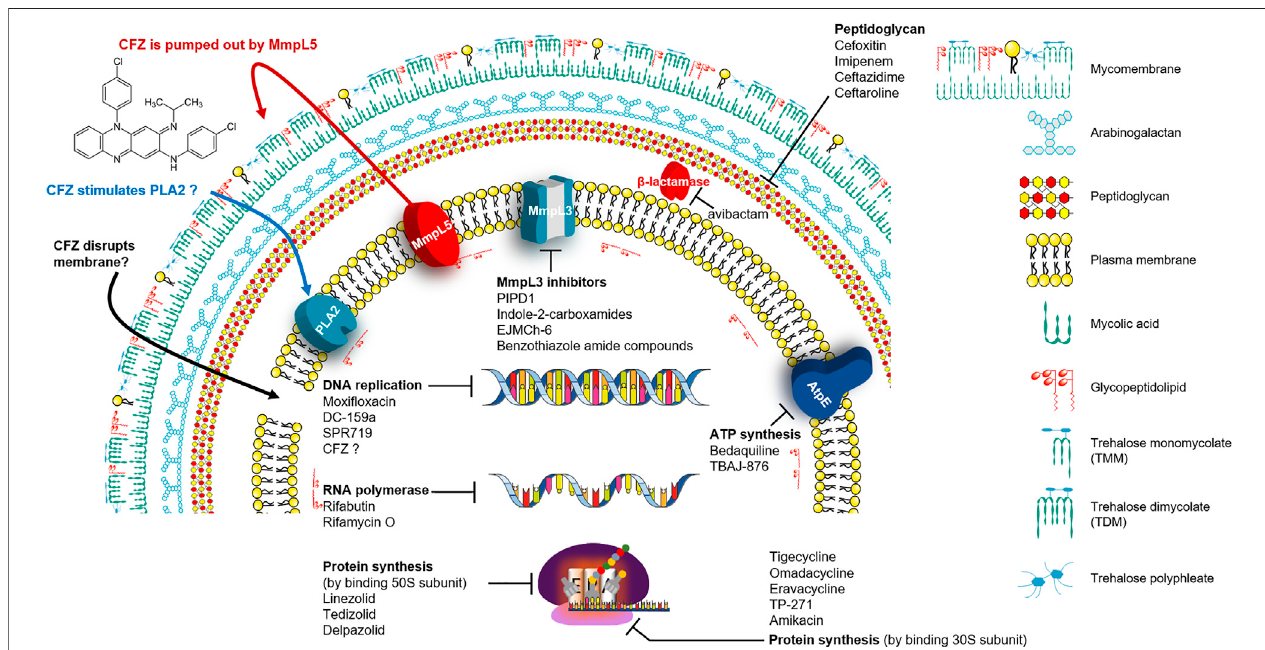
FIGURE 1 | Mechanisms of action (MOA) of anti- Mab drugs and drug